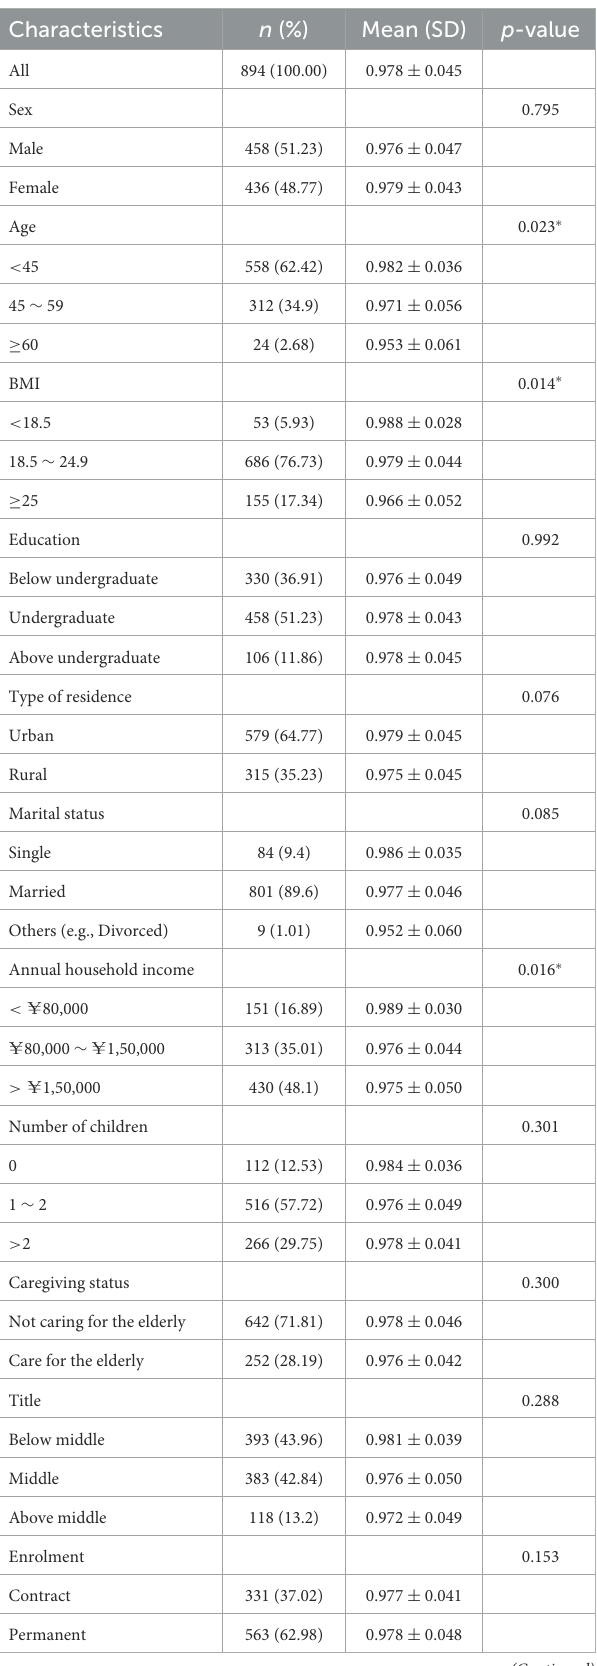
TABLE 1 Sociodemographic characteristics, lifestyle behaviors, and